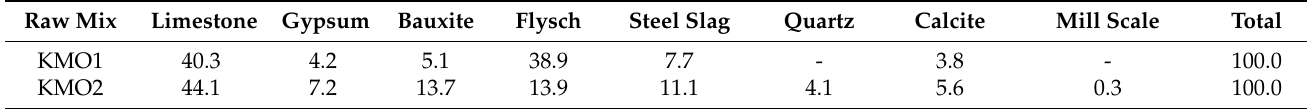
Table 3. Raw mix design